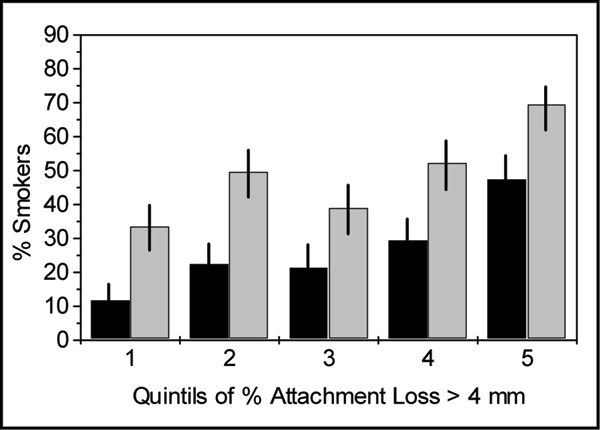
Proportion of smokers among subjects of increasing extent of periodontal disease as shown by quintiles according to Fig. 2. Black bars: current smokers only, gray bars: current and quitted smokers (ever).